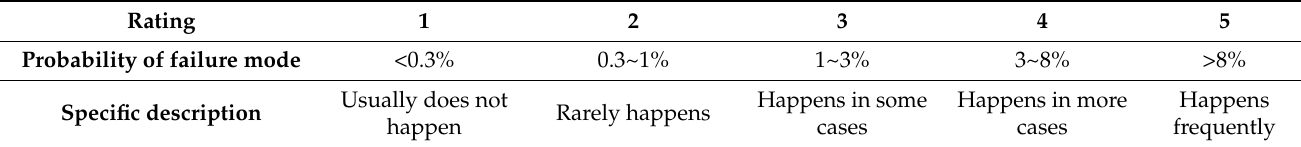
Table 7. Classification levels of failure probability.